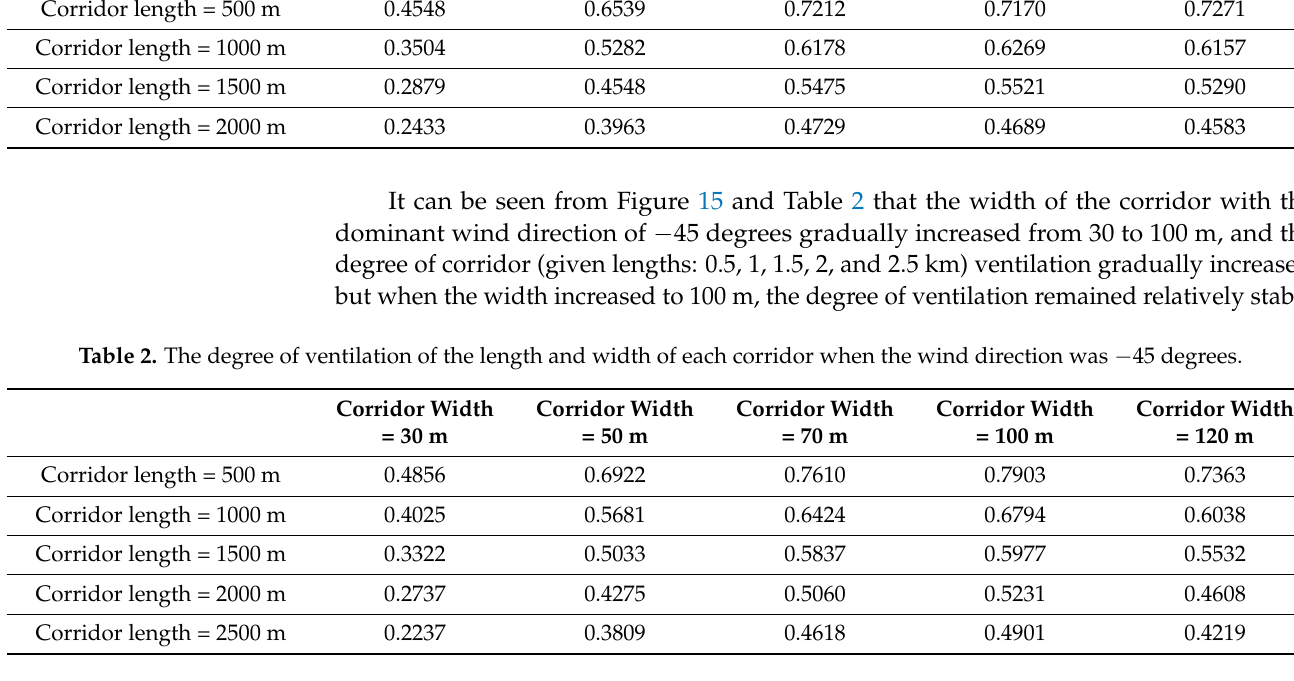
Figure 14. Ventilation conditions of various corridor widths with a − 67.5 degree wind direction. Table 1. Ventilation degree of each corridor length and width when the wind direction was -67.5 degrees. Corridor Width Corridor Width Corridor Width = 30 m = 50 m = 70 m